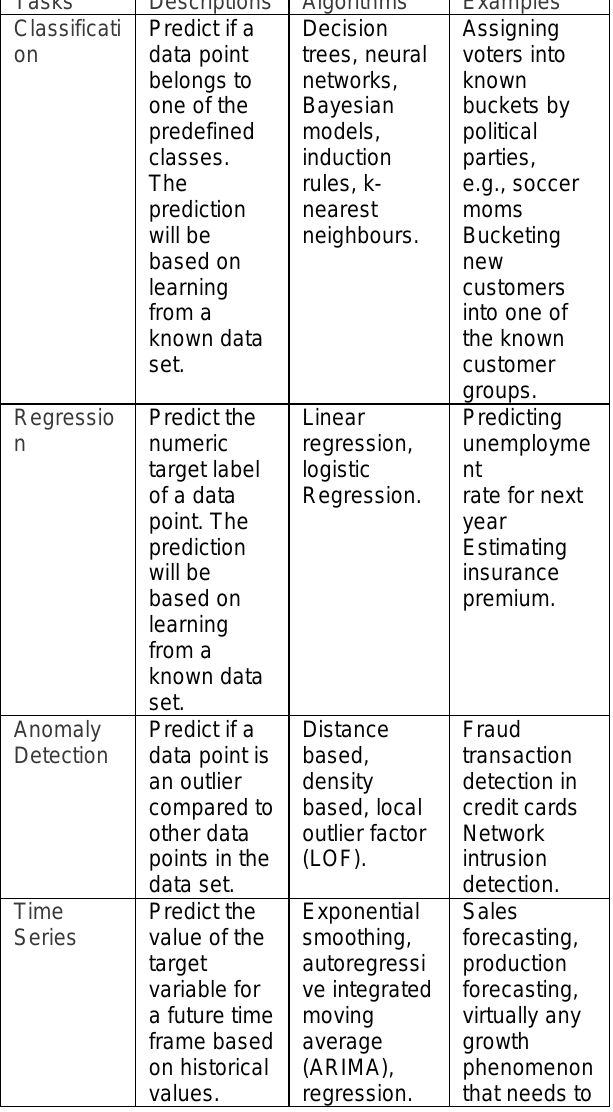
Table 1. Data mining algorithms